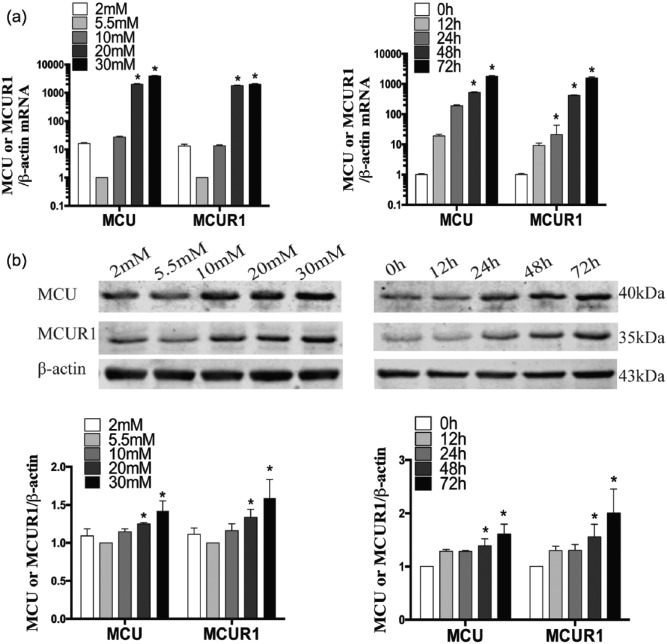
MCU and MCUR1 mRNA and protein expression in HUVECs cultured in the presence of HG. (a) Cells were treated with different glucose concentrations (2, 5.5, 10, 20 and 30 mM) for 72 h, and HG (30 mM) for various periods (0, 12, 24, 48 and 72 h). (b) MCU, MCUR1 and β-actin (the latter as a loading control) mRNA and protein levels were evaluated by real-time PCR and western blotting, respectively. Data are expressed as the means ± SEM of three independent experiments. Results were analysed by unpaired t-test. *p < 0.05 versus the NG group.